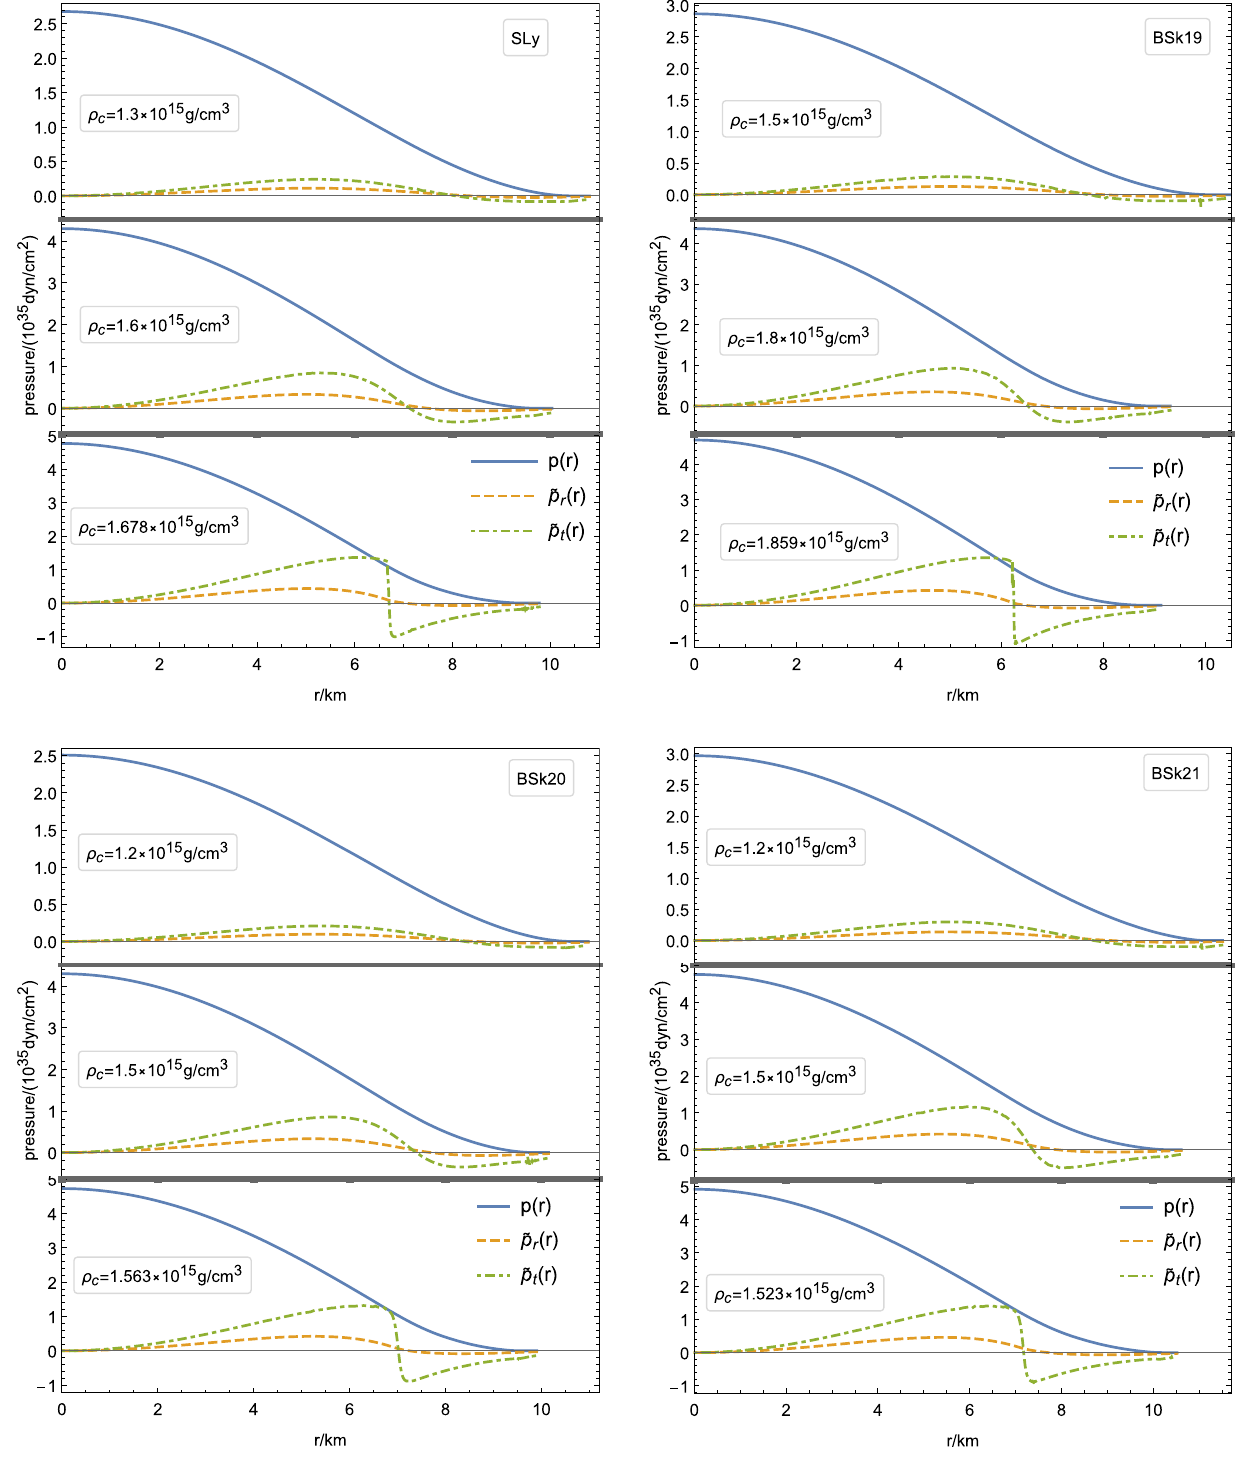
Fig. 4 Pressure profiles, as well as the profiles of the effective radial and transverse pressures of the f ( T ) fluid , for SLy, BSk19, BSk20, and BSk21 EOSs with α = 10 r 2 g and several representative values of ρ